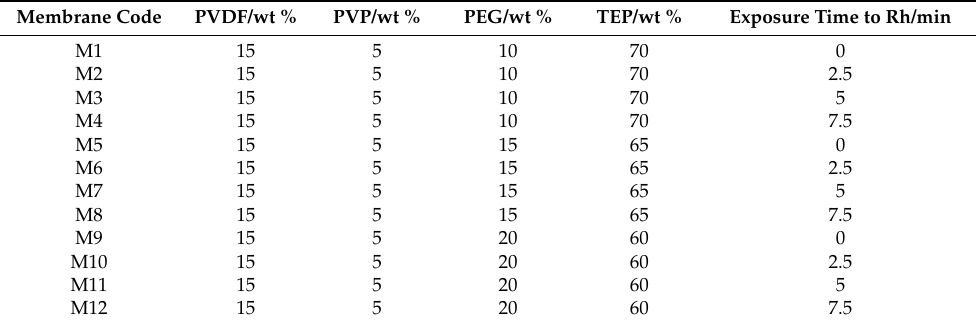
Table 3. PVDF membranes produced by varying casting solution composition and exposure time to fixed humidity and